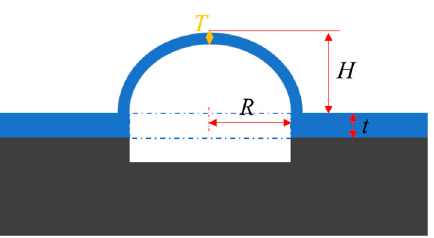
Figure 2. Dimensional sketch of hemispherical shell.